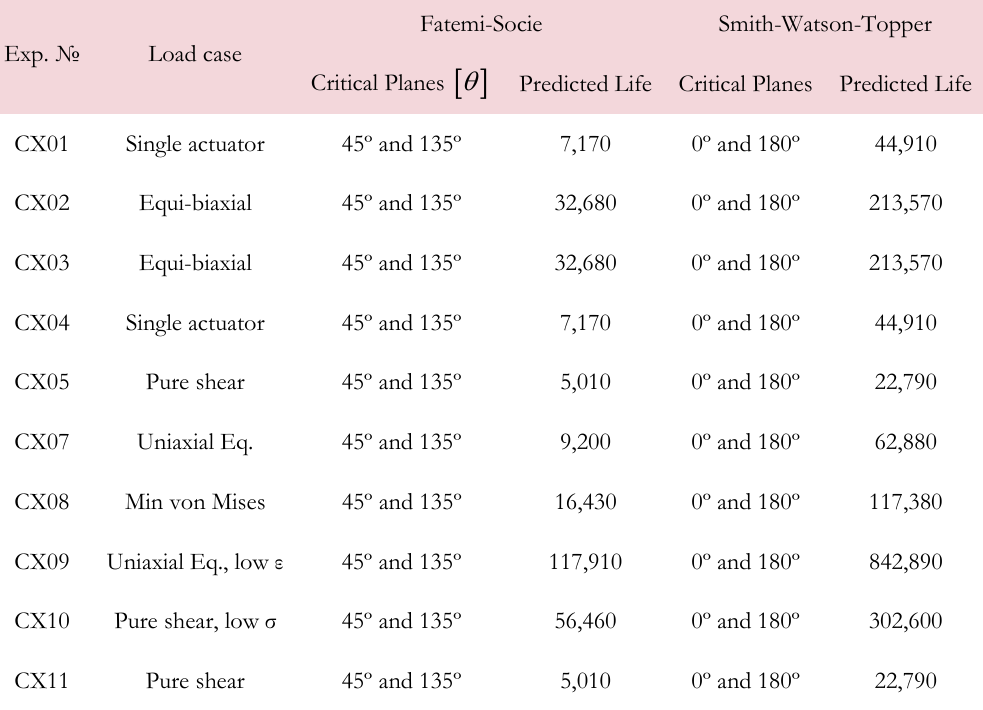
Table 3: Fatigue life predictions with Fatemi-Socie and Smith-Watson Topper